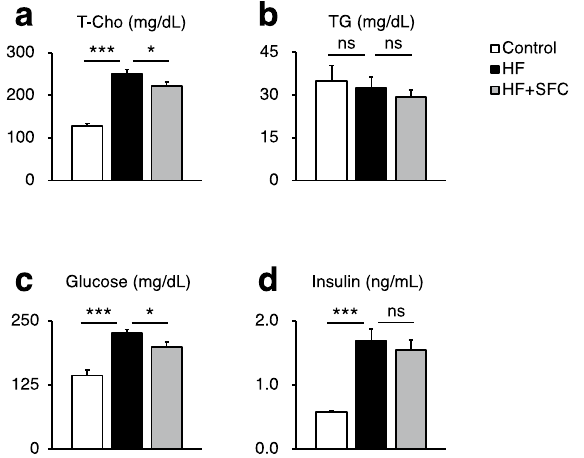
Figure 2. Metabolic parameters. ( a – d ) Male C57BL/6 J mice of 6 weeks of age were fed with each diet for 15 weeks as specified in Fig. 1. ( a , b ) Plasma levels of ( a ) total cholesterol (T-Cho); and ( b ) triglycerides (TG) in C57BL/6J mice after 15 weeks on different diets ( n = 5–6). ( c , d ) ( c ) Blood glucose; and ( d ) plasma insulin levels after 8 weeks on different diets ( n = 12). Data are expressed as mean ± SEM values. Statistical